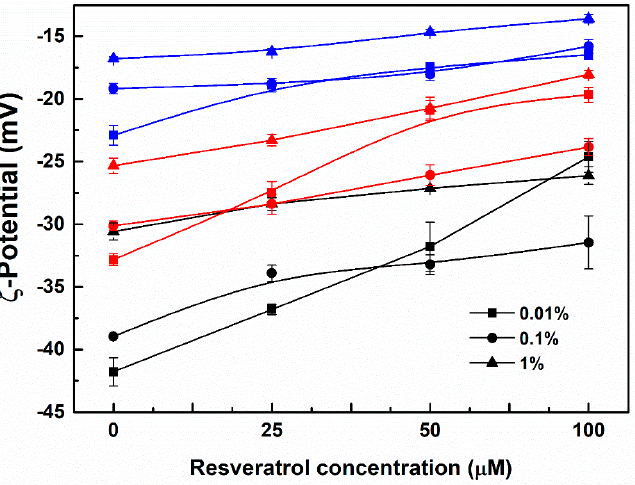
Figure 3. ζ − Potential of WPI (black), SC (red) and SPI (blue) particles in the absence and presence of 25, 50 and 100 µ M resveratrol. The protein concentrations were 0.01%, 0.1% and 1%. ζ − Potential absolute values of the protein particles decreased as the concentration of resveratrol increased, which was most pronounced at the protein concentration of